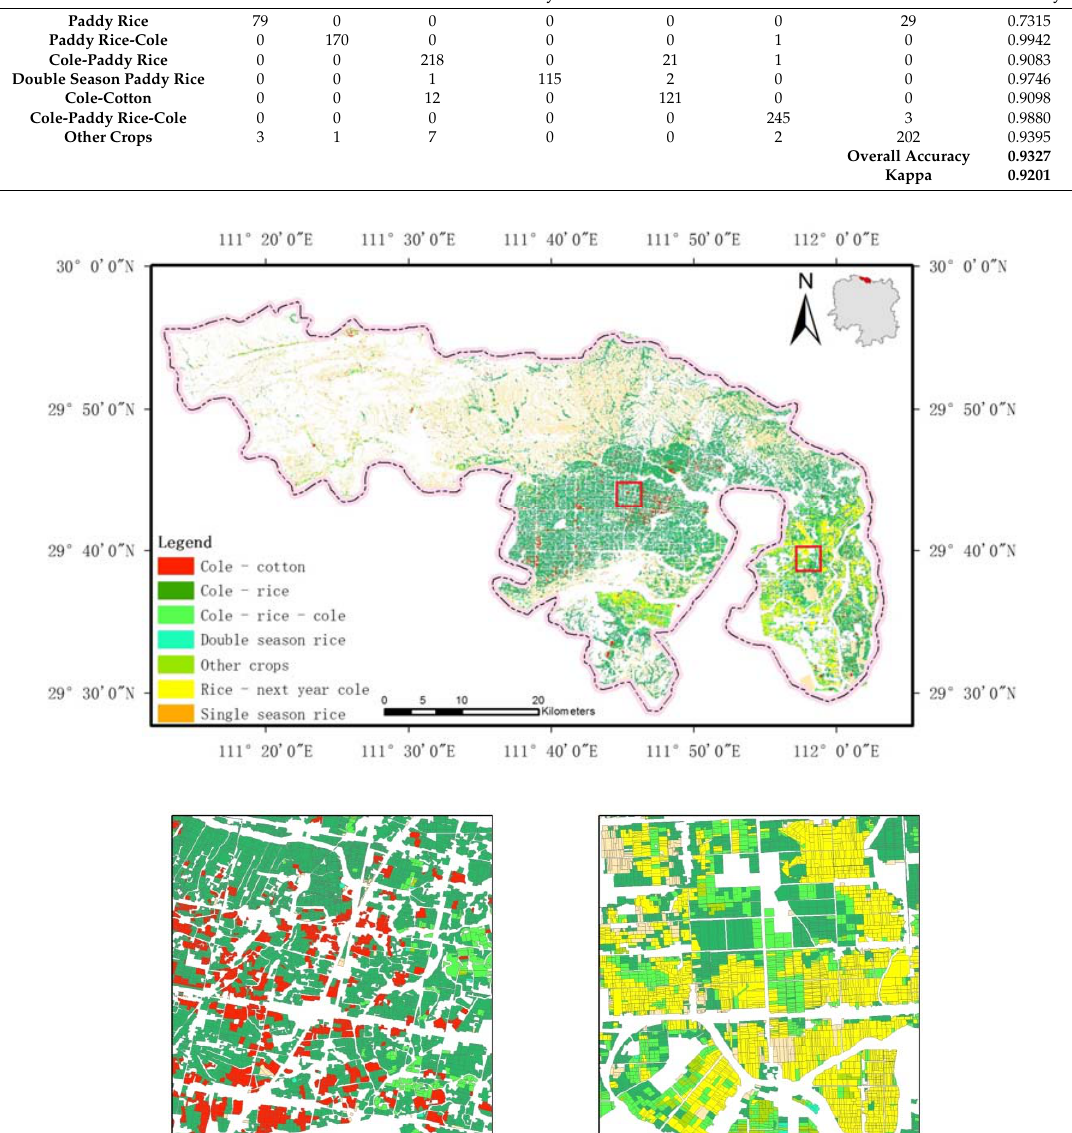
Table 3. Confusion matrix of classification using phenological features and spectral features. All Features